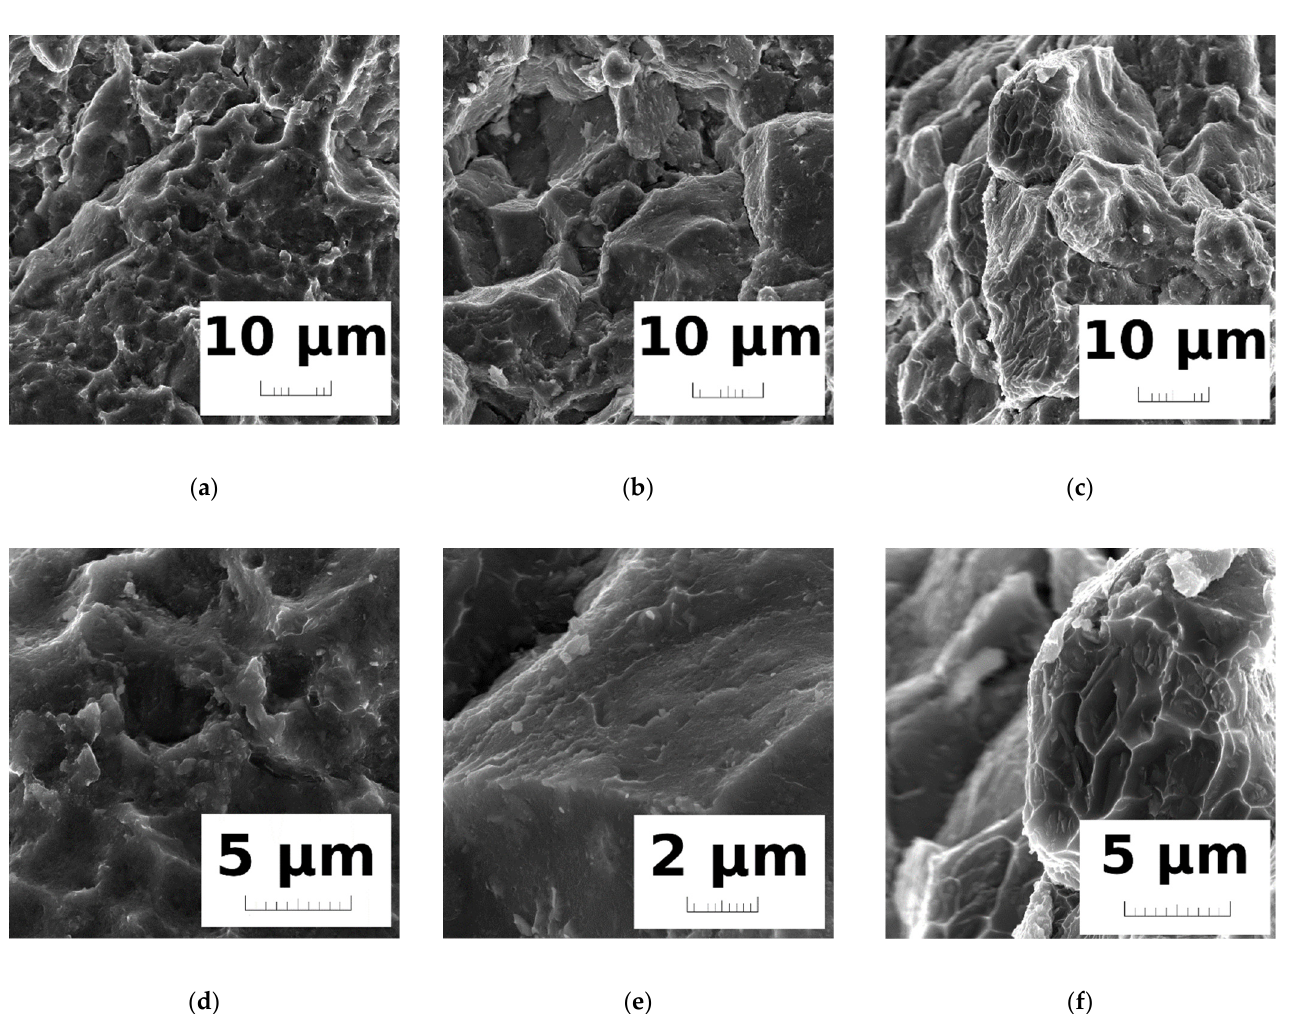
Figure 11. Fractography micrographs of SPSed AA7075 after tensile tests showing: dimples indicating occurrence of mostly brittle fracture ( a , d ); cleavage features ( b , e ); dimples together with cleavage features ( c , f ).